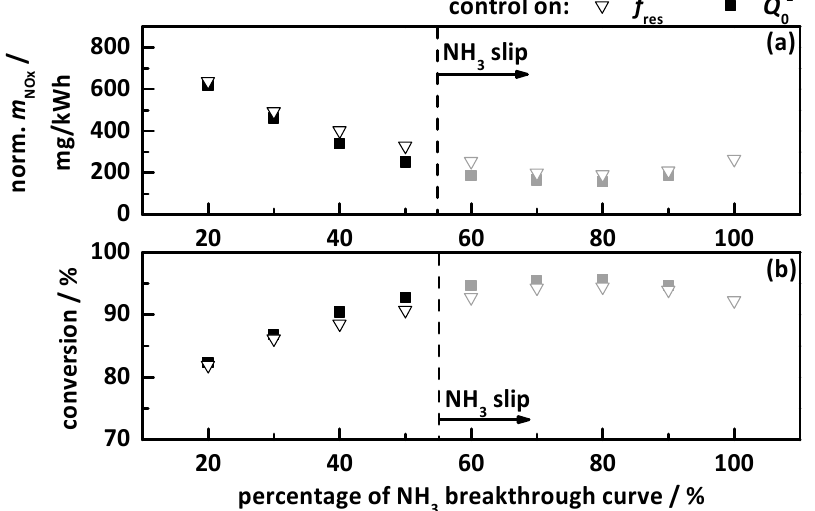
Figure 9. Results of the transient study for the control on percentage gradation of the NH 3 breakthrough curve by f res (hollow triangles) and Q 0 − 1 (filled squares), with ( a ) the apparent emitted and normalized NO x mass in mg/kWh as determined by the downstream NO x sensor, and ( b ) the resulting apparent NO x conversion within the test cycle. The storage curves right to the dashed line (grey marked) caused NH 3 slip.